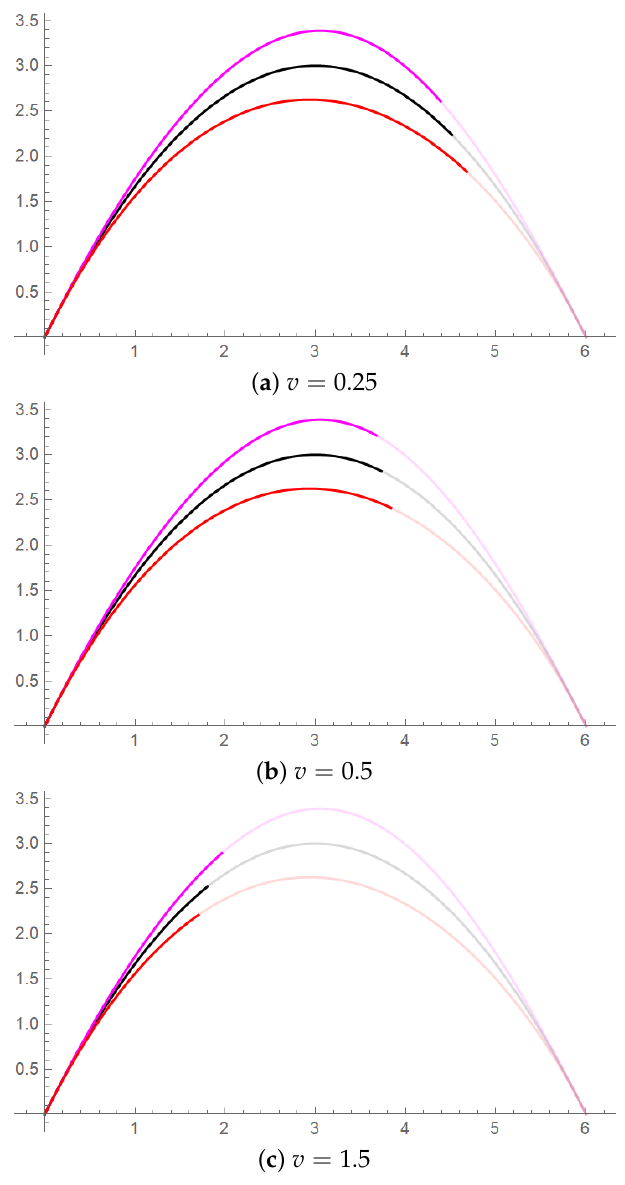
Figure 7. Cubic fractional Bézier curve with different fractional parameter and shape